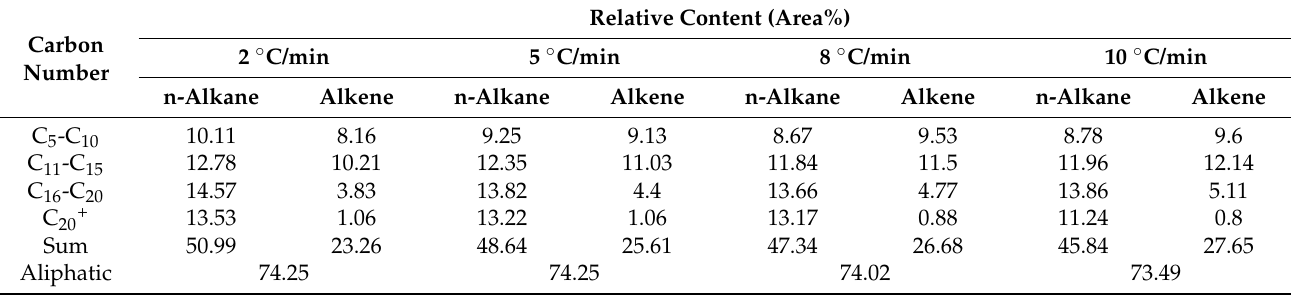
Table 8. Carbon number distribution of n-alkanes and